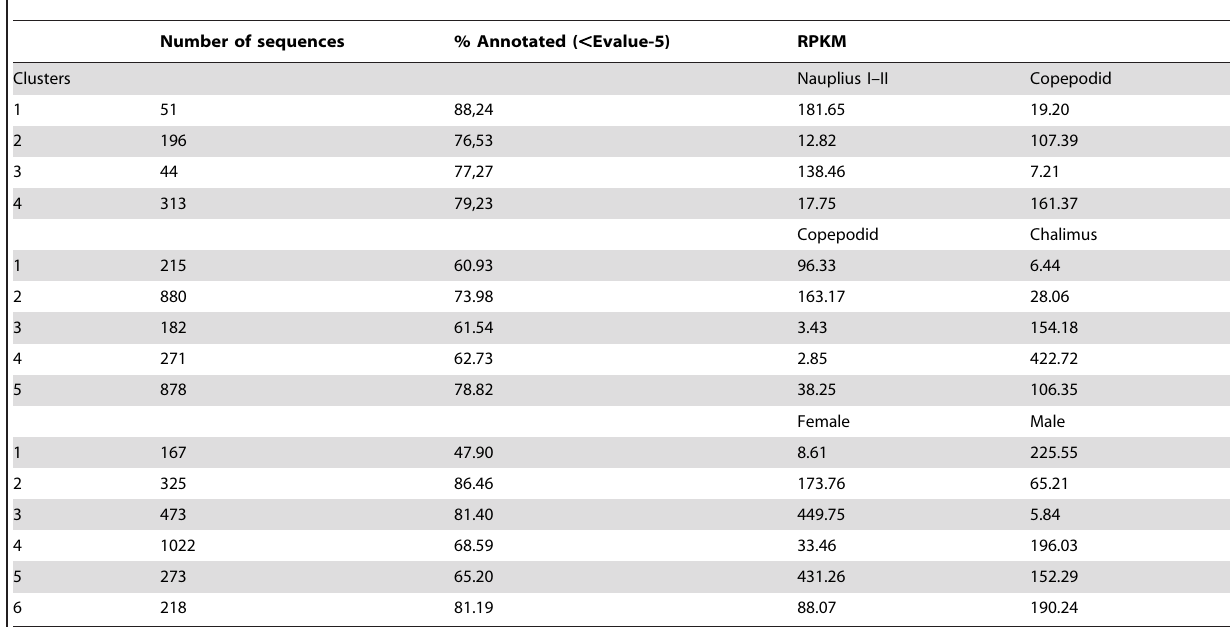
Table 2. Summary of clusters between Nauplius I–II/Copepodid, Copepodid/Chalimus, and Female/Male groups from C. rogercresseyi